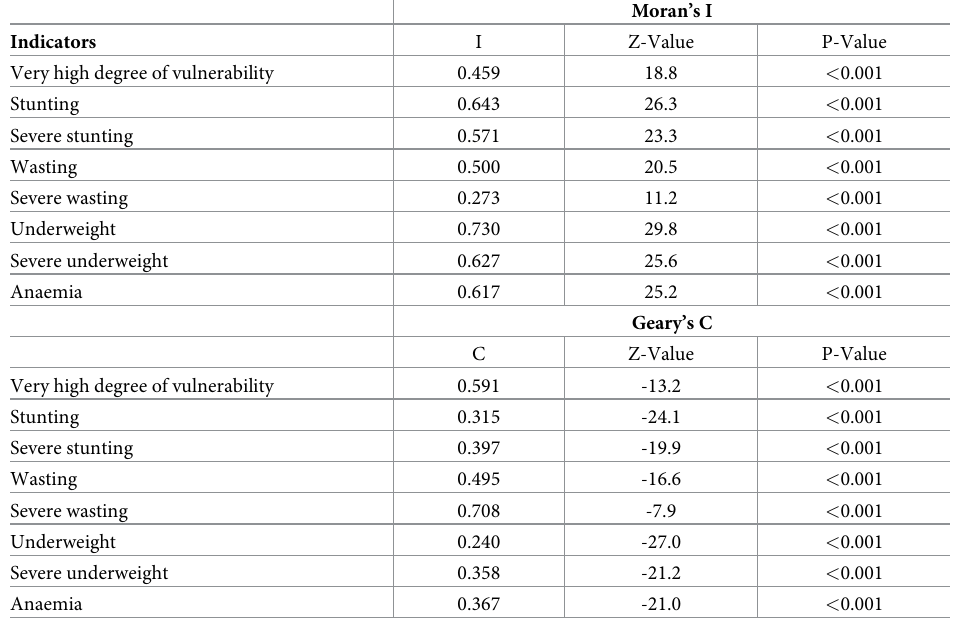
Table 3. Moran’s I and Geary’s C values assessing degree of autocorrelation in degree of vulnerability and nutri- tion status of